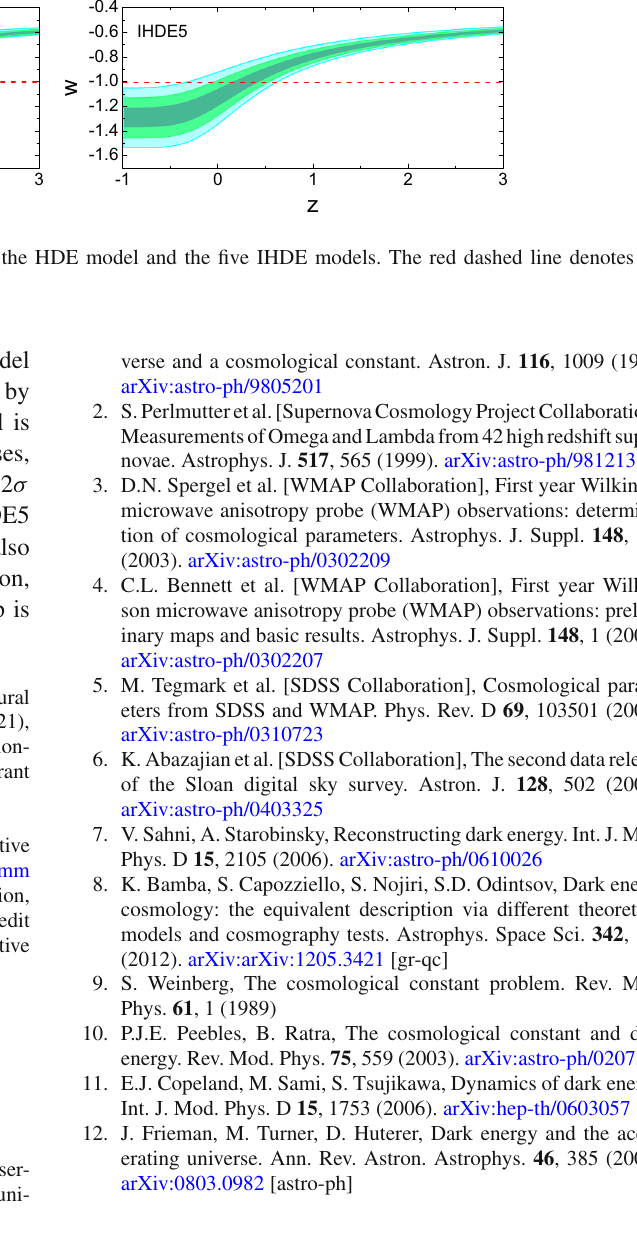
ρ ρ c de ρ + ρ c de